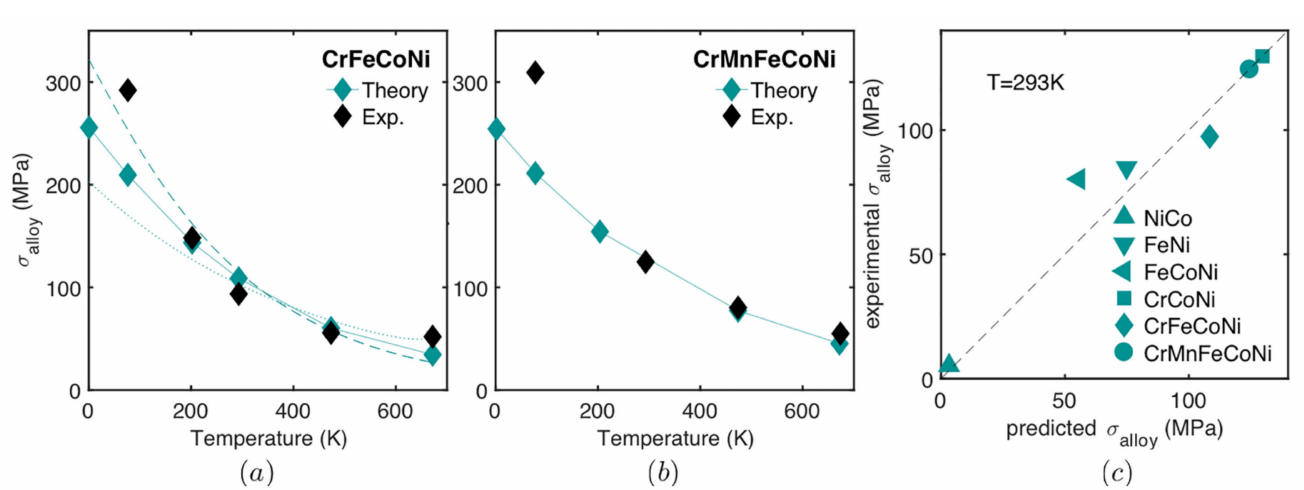
Figure 5. Comparison of experimental and theoretical values in terms of yield strength as a function of temperature ( a ) of NiCoFeCr and ( b ) FeNiCoCrMn equiatomic HEAs. ( c ) Experimental yield strength as a function of predicted yield strength for Ni-Co-Fe-Cr-Mn family at T = 293 K. Hall-Petch contribution to strength has been subtracted. Adapted from